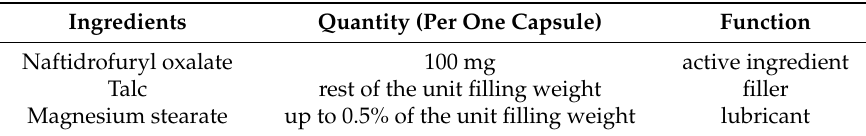
Table 2. Composition of the developed in-house NF